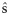
Single-trial prediction and detection of sensory-evoked responses in the awake mouse.A. Recordings of whisker-evoked neural activity in the principal barrel column were acquired using a laminar probe in awake mice. B. A single trial response to the punctate whisker stimulus (galvanometer trace, pink line at top), showing LFP activity across the 32 channels of the silicon probe (25 μm spacing), with 1 s of pre-stimulus activity (xprestim, horizontal blue bar) and the sensory-evoked response starting at the time point indicated by the arrow (pink). C. Average spatial profile of evoked LFP at t = 10 ms post-stimulus (left). Right: average evoked CSD over the 25-ms post-stimulus window, with color indicating whether sink (red) or source (blue). Channels were assigned to layers (dashed horizontal lines separating sections labeled L2/3, L4 and L5) by centering the largest evoked response in layer 4. D. State-blind analysis (top row, black font): Neural responses encode sensory inputs, described by the encoding distribution P(x|W) of response (x) conditioned on stimulus identity (W, here the presence (+) or absence (−) of a sensory input). An ideal observer determines the stimulus from the response using P(W|x). State-aware analysis (bottom row, blue font): sensory responses also depend on cortical state (s). Here we estimate s^ by computing a function of the pre-stimulus neural activity (xprestim). An ideal observer sets a state-dependent threshold depending on the estimated state s^. Figs 2–4: estimation of s^. Figs 5 and 6: state-aware ideal observer analysis using P(W|x,s^). E-H. Illustration of the detection framework applied to an example drawn from recorded data. E. The recorded LFP in layer 4 is shown for three example trials, with W = "+" (top two) and W = "−") (bottom). F. Expanded view of neural activity in a 25-ms window (gray boxes in (E)). In these selected examples, spontaneous fluctuations (W = "−") are larger than the first sensory-evoked response (W = "+"). G. The state classifier (described in Figs 2–4) estimated state ŝ for each trial based on ongoing/pre-stimulus activity. H. Illustration of detection of input (W = "+" or W = "−") based on state-blind threshold choice (black, P(x|W)) and based on state-aware threshold choice (blue, P(x|W,s^)). In this example, the threshold for state 2 was increased to reject the spontaneous activity (bottom row), while the threshold for state 1 was decreased to accept the small sensory-evoked responses.